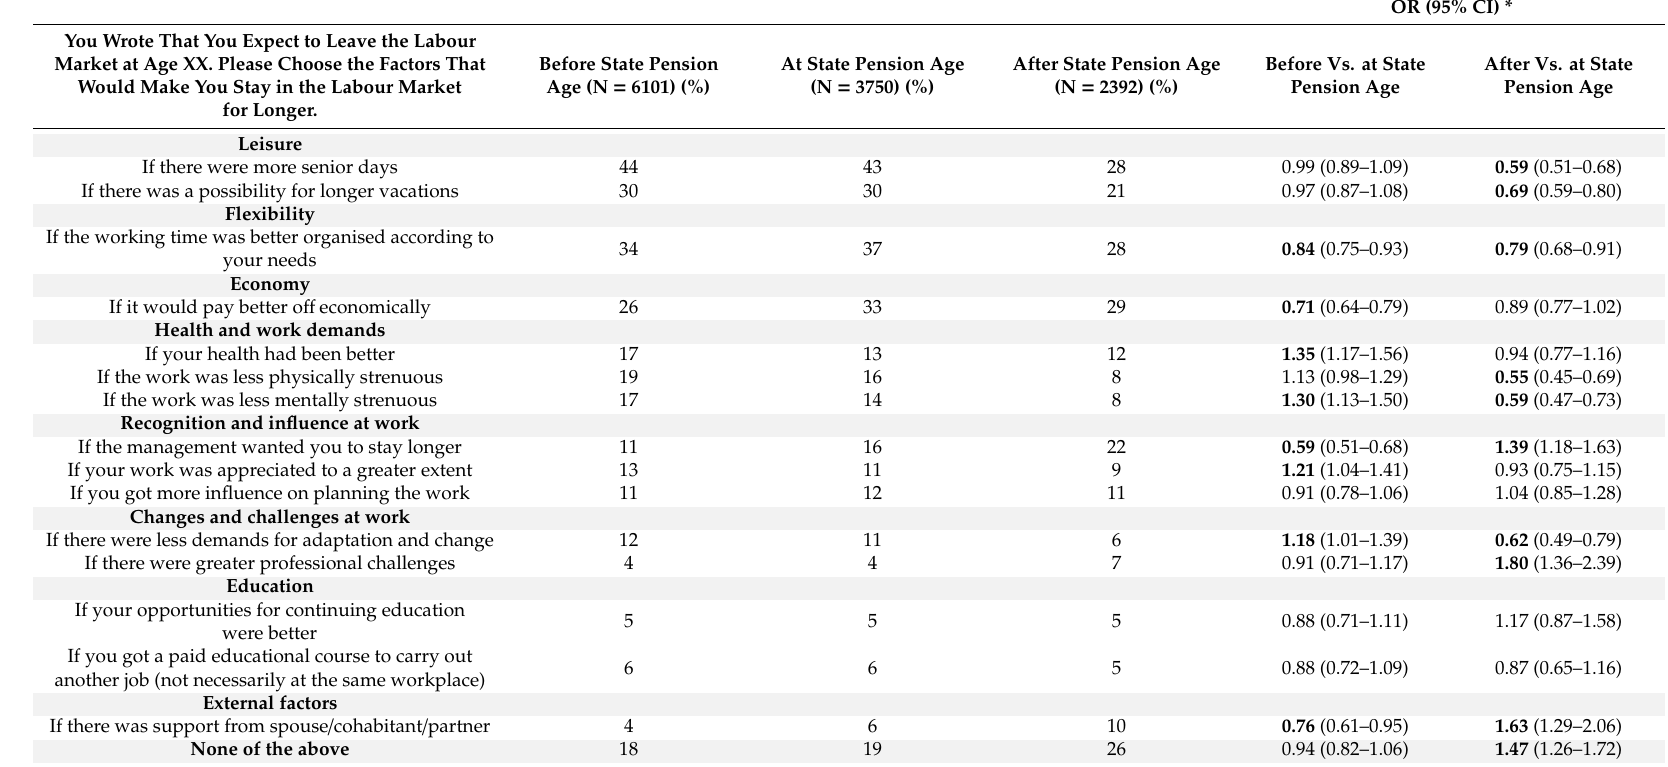
Table 3. Possible reasons for prolonging work